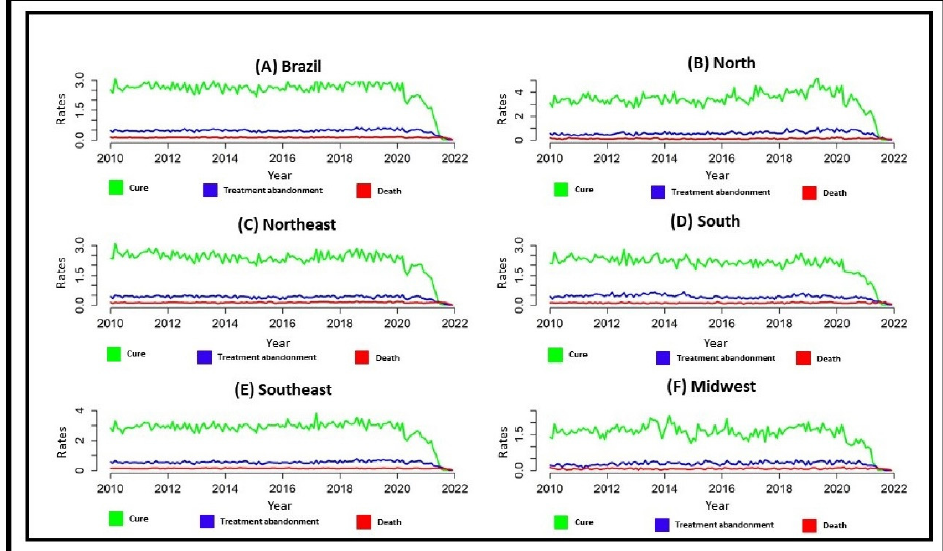
Figure 2. Monthly time series of tuberculosis outcomes in Brazil and its macro-regions (2010–2021).